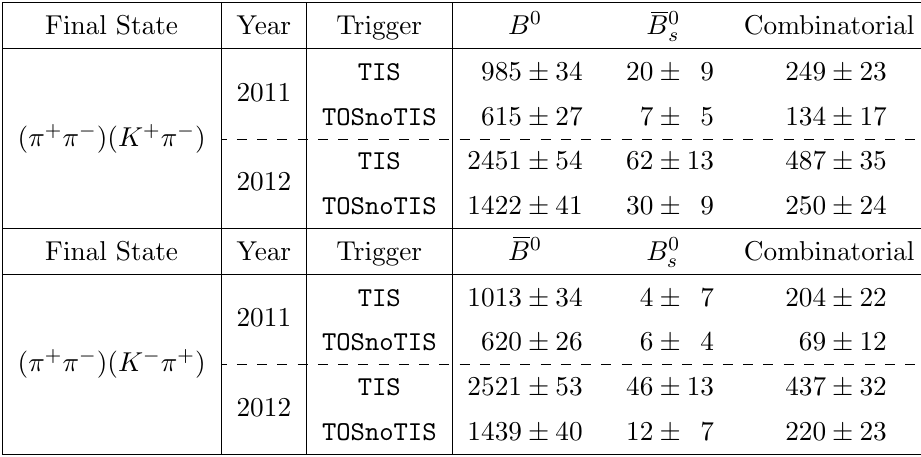
Table 1. Yields obtained in the extended simultaneous four-body invariant mass (cid:12)t to the four categories and for the two (cid:12)nal states. The quoted uncertainties are statistical only.